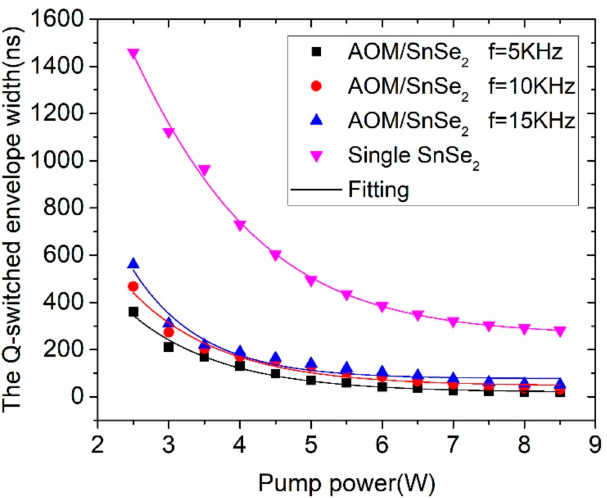
Figure 6. The variation of Q-switched envelope width for QML lasers with different modulation methods.